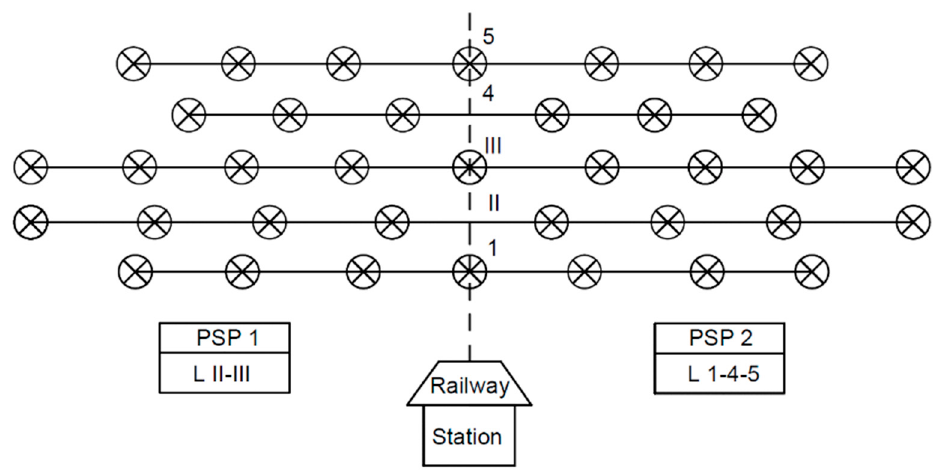
Figure 4. Platform lighting scheme for a railway station. PSP = power supply panel; L = rail line, Roman numerals = direct lines; Arabic numerals = branching lines.